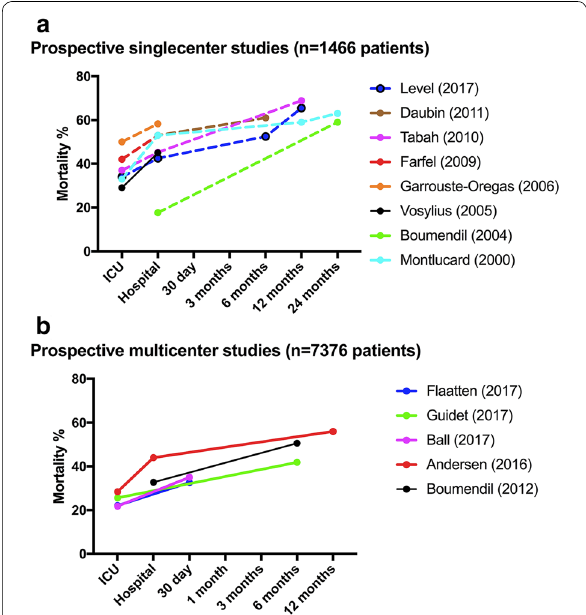
Fig. 3 Mortality. a Represents mortality rates in critically ill elderly patients following admission to the ICU at ICU and hospital discharge, at 30-day and 3, 6, 12 and 24 months in single-center studies from 2000 to 2017. b Represents mortality rates in critically ill elderly patients following admission to the ICU at ICU and hospital discharge, at 30-day and 3, 6, 12 and 24 months in multicenter studies